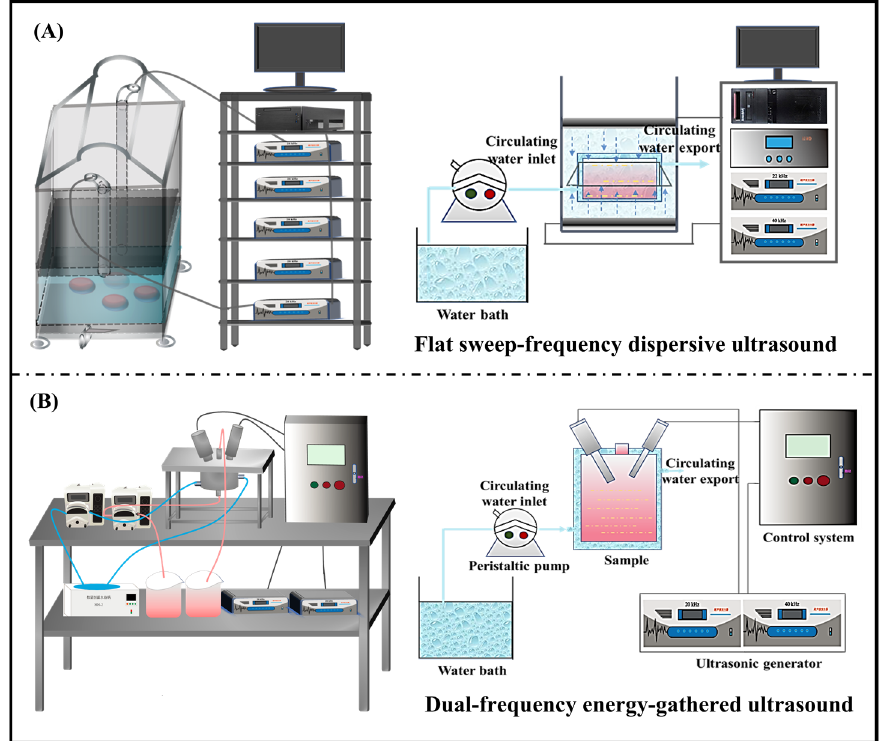
Figure 1. Design of multi-frequency ultrasound devices. ( A ) Flat sweep-frequency divergent ultra- sound. ( B ) Dual-frequency energy-gathered ultrasound.